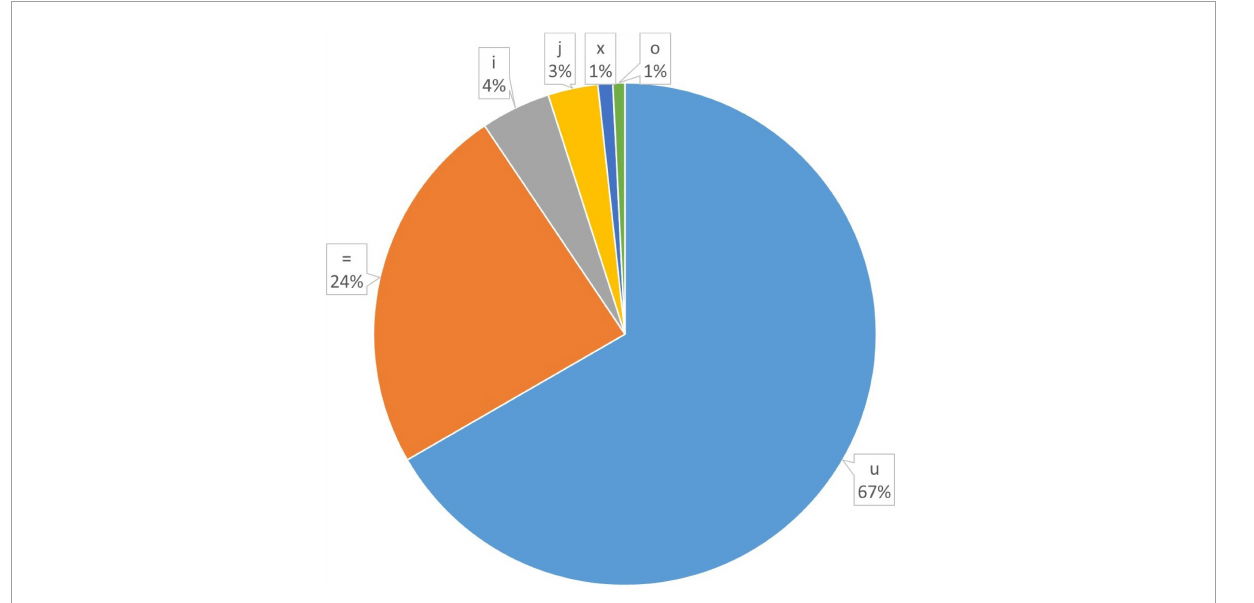
FIGURE4 Classification of predicted lncRNAs based on their genomic